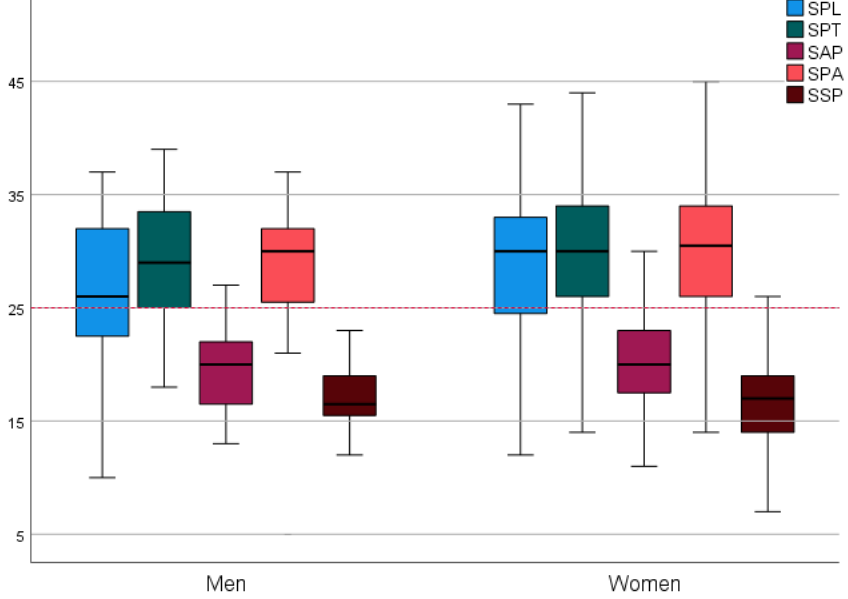
Figure 2. Gender comparison in subscales.